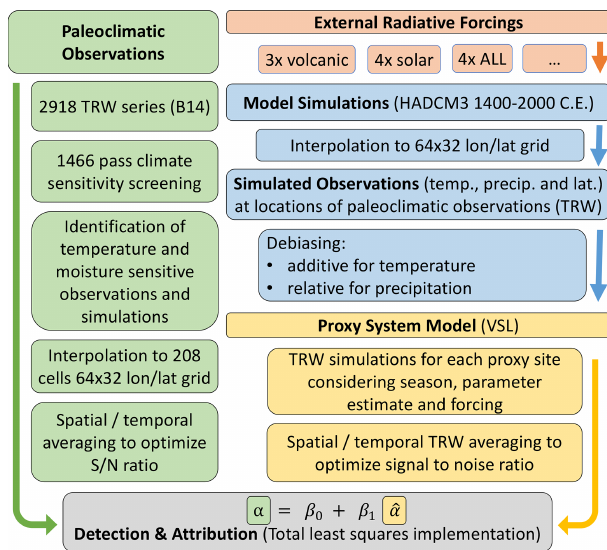
Figure 1. Schematic overview of the performed analysis. General steps are indicated in bold, and study-specific procedures are shown in roman text. B14 refers to the Breitenmoser et al. (2014) dataset, S/N stands for signal to noise ratio, T stands for temperature and PREC stands for